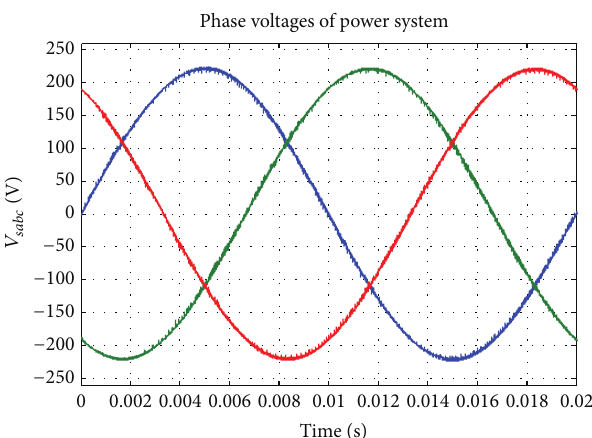
Figure 6: Zoom of power system phase voltages.